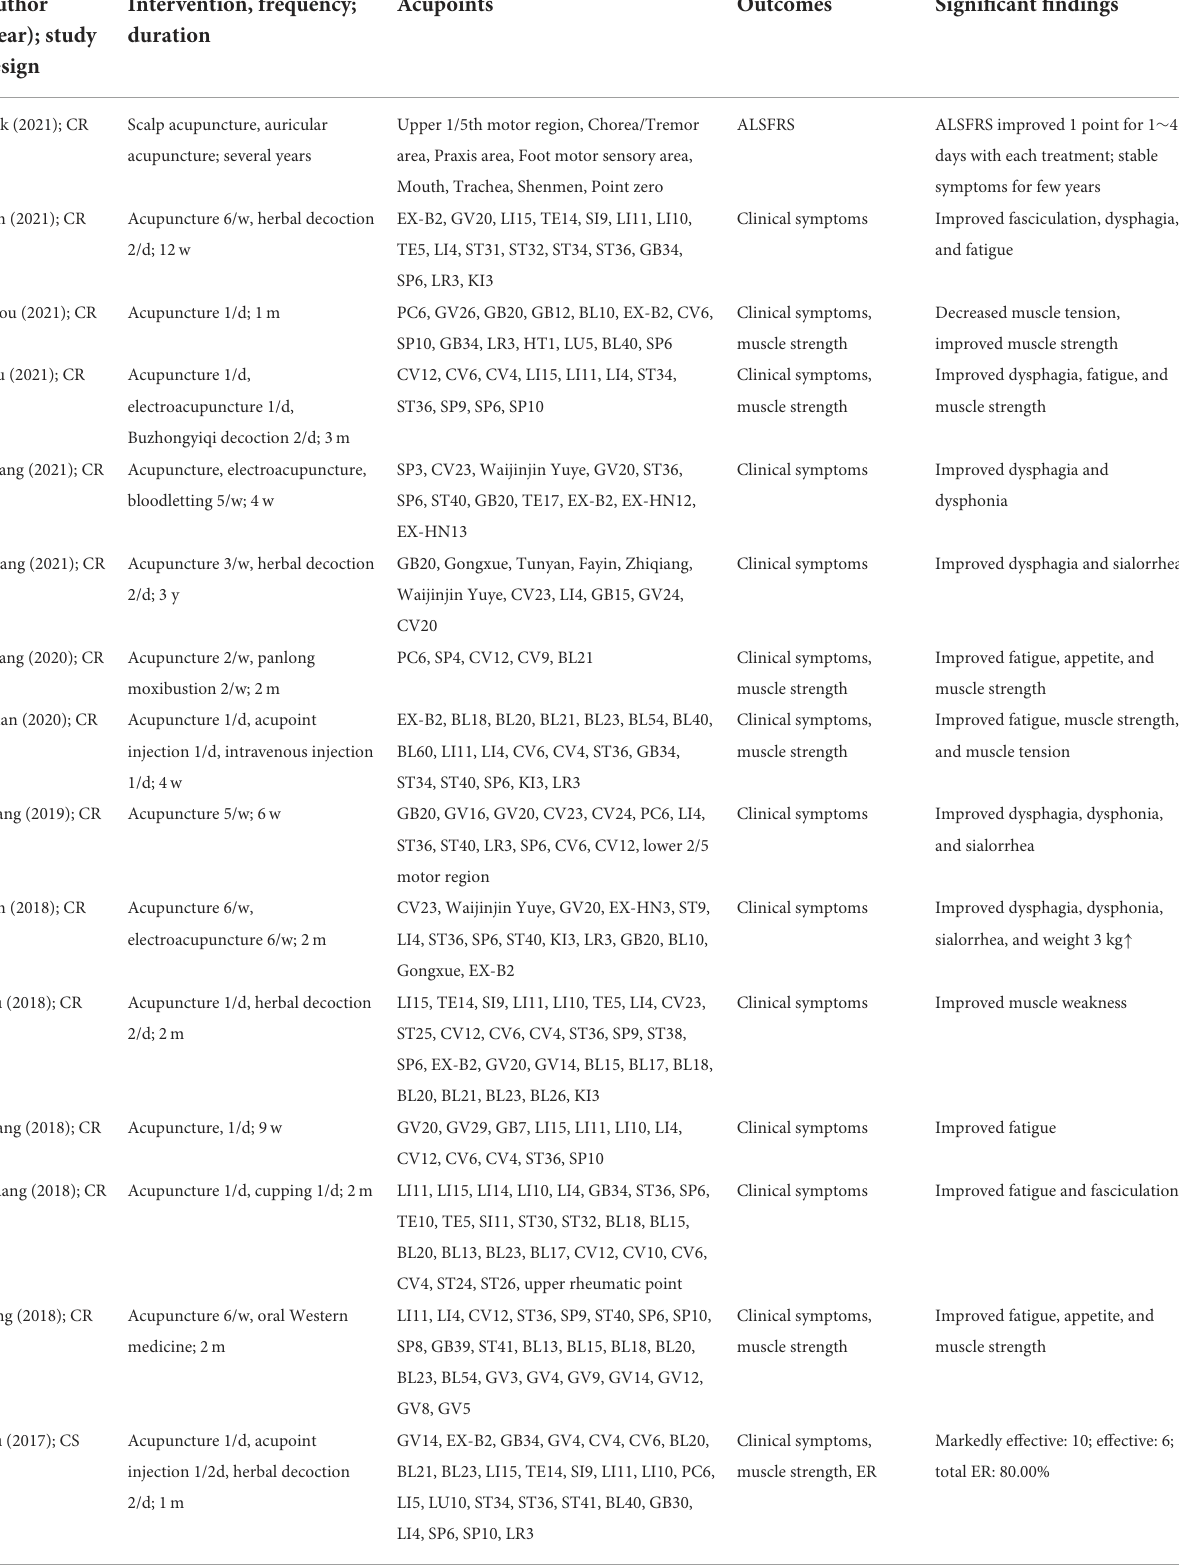
TABLE 4 Summary of included observational